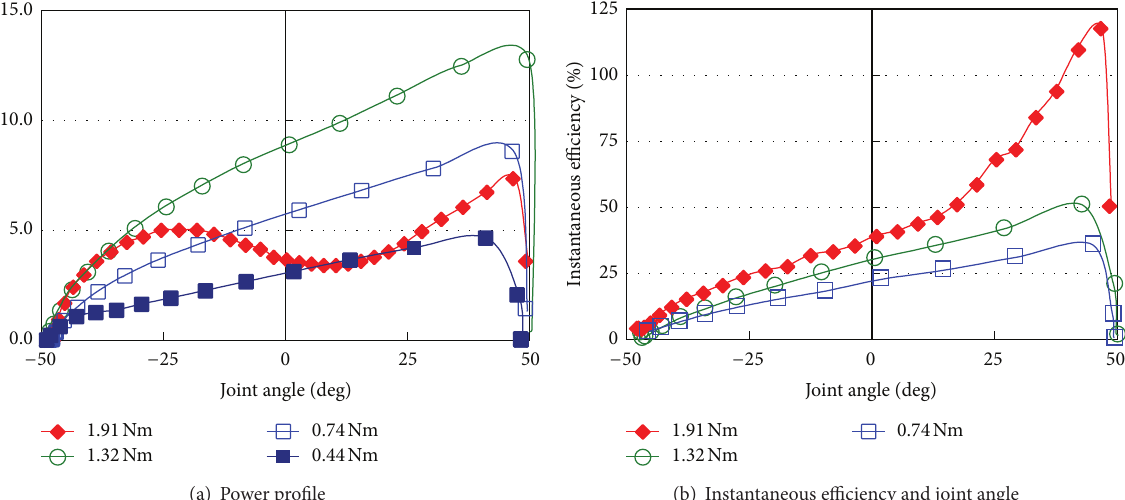
Figure 15: Result of load lifting motion.